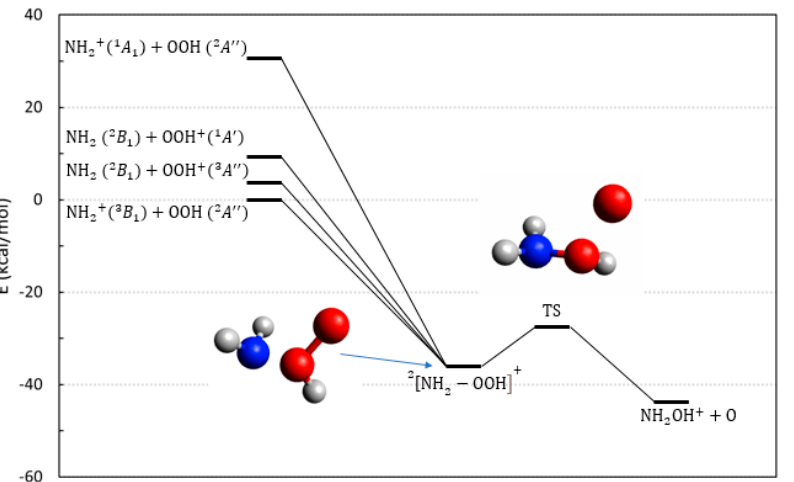
Figure 4. Energetic scheme of the possible entrance and exit channel of reactions 7 – 10 involving the system [ NH 2 − O 2 H ] + with doublet multiplicity. The structure of the ground state intermediate complex and that of the transition state toward the product (O–O bond break) are also shown. En- ergies computed at CCSD(T)/Def2-TZVPP level.